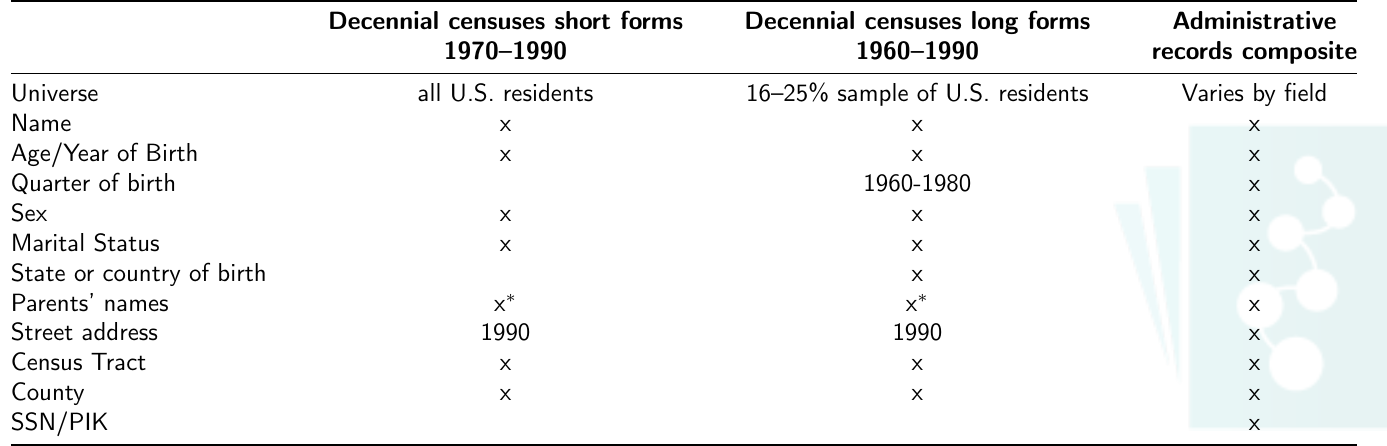
Table 2: Linkage variables in 1960–1990 censuses and the administrative records composite